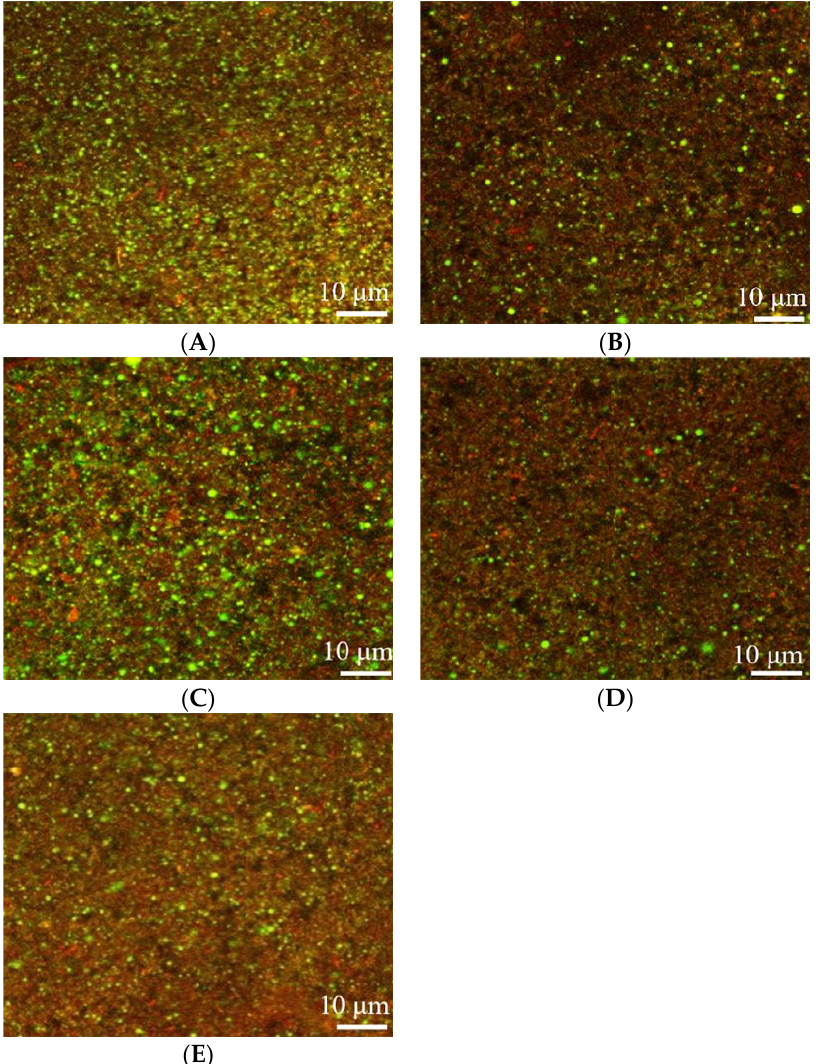
Figure 4. Effects of oat β -glucan concentration on the microstructure of pea-protein-based yogurt: ( A ) yogurt prepared with 3% oil, ( B ) yogurt prepared with 1% oil, ( C ) yogurt prepared with 1% oil and 0.25% oat β -glucan, ( D ) yogurt prepared with 1% oil and 0.5% oat β -glucan, and ( E ) yogurt prepared with 1% oil and 1% oat β